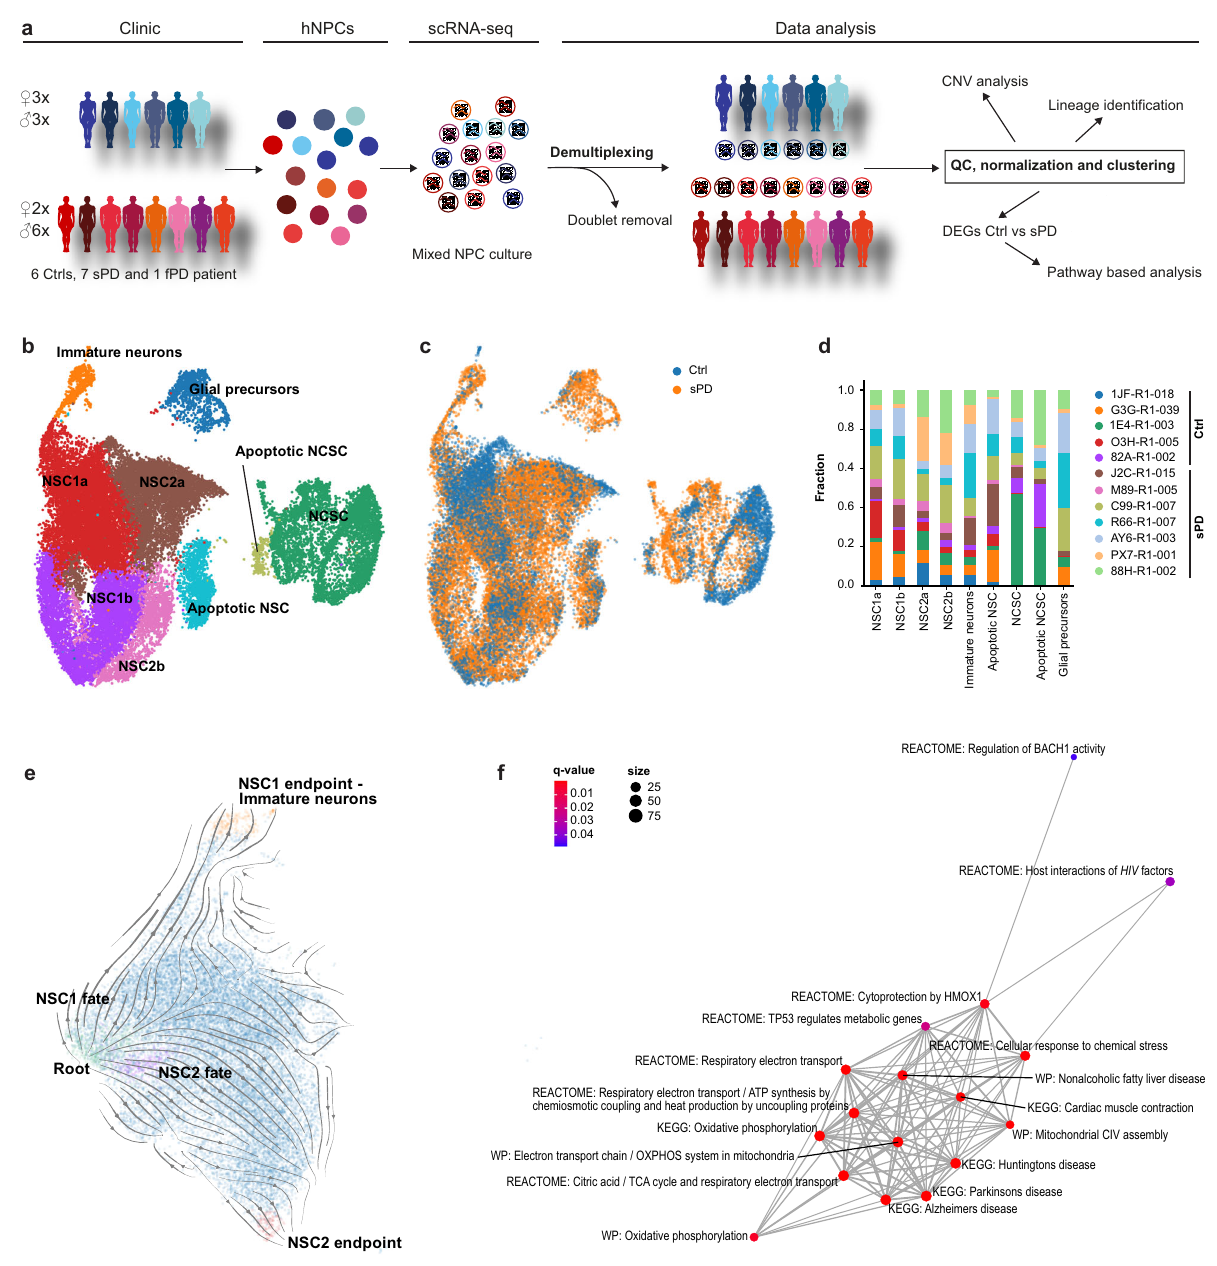
Fig. 3 | scRNA-seq pro fi ling and clustering. a Experimental and bioinformatic work fl ow for multiplexing of 14 hNPC clones derived from 13 individuals. QC, quality control. b UMAP visualization of 30,557 annotated cells from 5 Ctrl and 7 sPD hNPC clones within the clusters NSC: neural stem cells, immature neurons, glial precursors, NCSC: neural crest stem cells and apoptotic NSC / NCSC. c UMAP visualization with annotations for the disease condition (Ctrl, sPD). d Contribution of individual patients to clusters. e RNA velocity analysis revealed two NSC